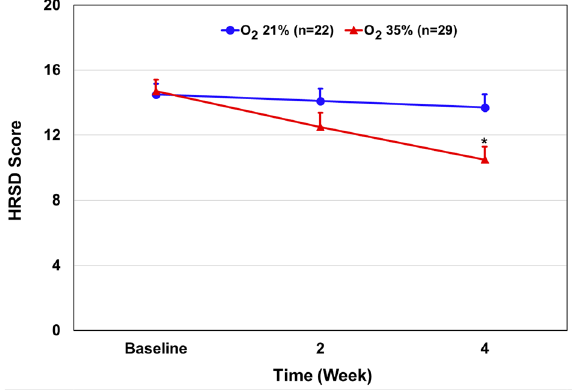
Figure 2. Effect of 35% oxygen treatment on total HRSD score. Results are presented as mean ± SEM. *Multivariate regression analysis: The mean ± SD changes in the scores from baseline to week four were − 4.2 ± 0.3 points in the oxygen-treated group and − 0.7 ± 0.6 in the control group, for a between-group difference of 3.5 points (95% confidence interval [CI] − 5.95 to − 1.0; P = 0.007).